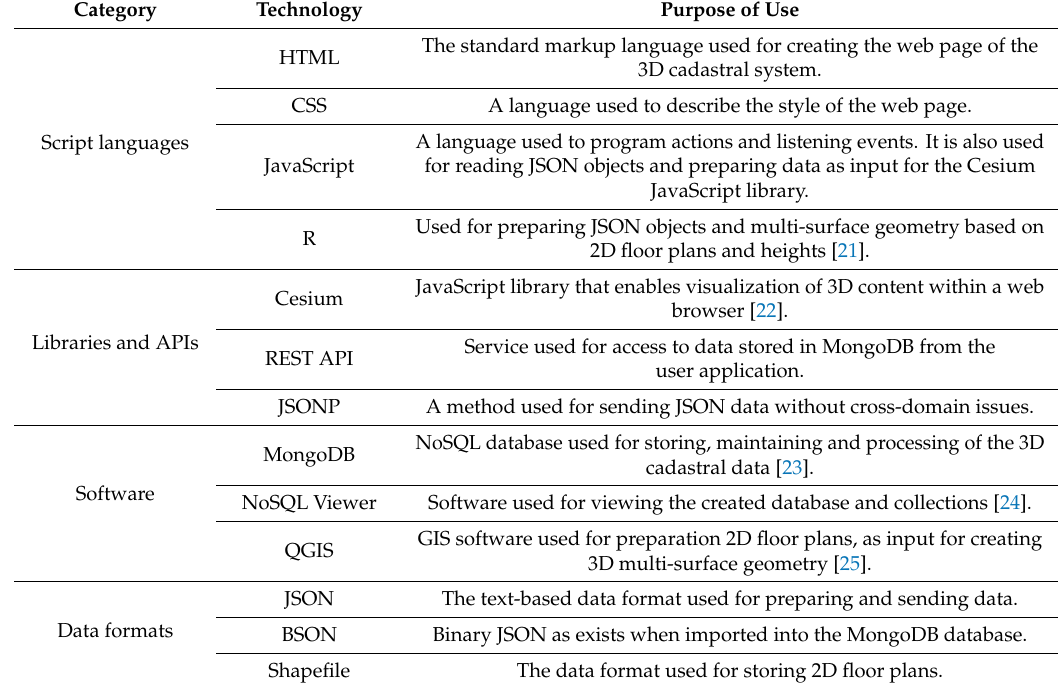
Table 1. Languages, libraries, APIs, software and data formats used for the development of the 3D cadastral system.